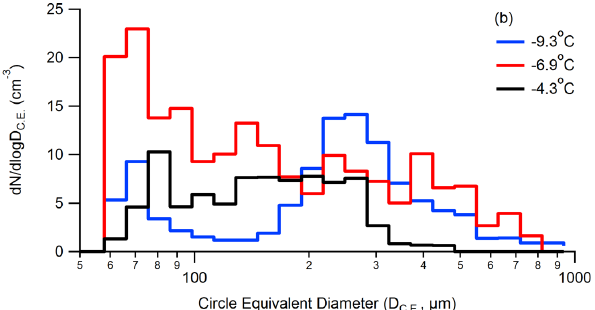
Fig. 12b. Ice particle size distribution from the 2D-S in the convec- tive region (15–25km distance from CFARR) in high ( > 1cm − 3 ) cloud droplet number concentration regions.